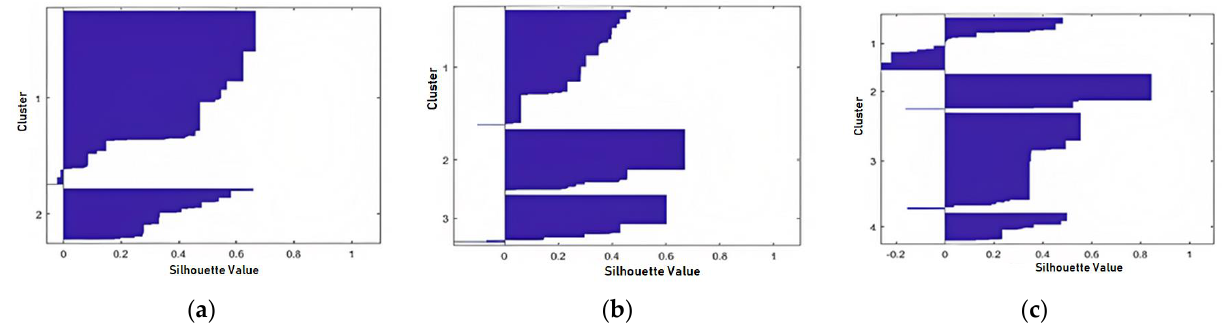
Figure 7. Clustering in: ( a ) 2 clusters, ( b ) 3 clusters and ( c ) 4 clusters.